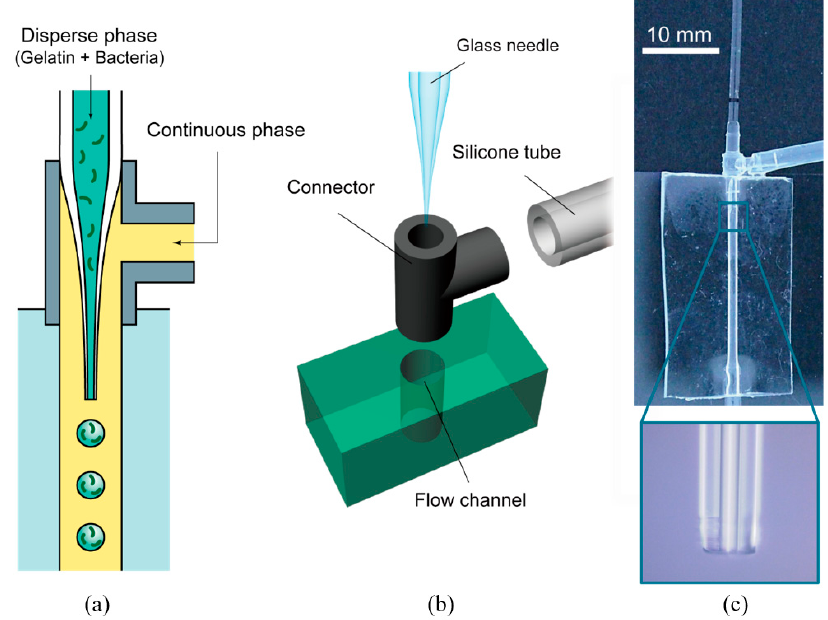
Figure 2. Microfluidic device for generating monodisperse gelatin microspheres. ( a ) The schematic illustration of the microfluidic device. Droplets of the continuous phase were formed at the tip of the glass needle. Prepared emulsion was collected at the end of the glass capillary in cold water. ( b )